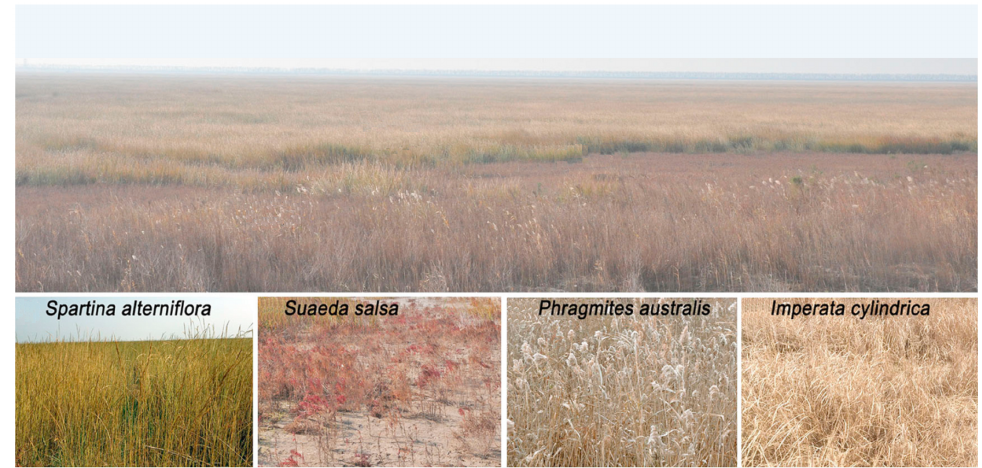
Figure 3. Salt marsh ecosystem in the middle coast of Jiangsu, China (33 ◦ 00 (cid:48) –33 ◦ 40 (cid:48) N, 120 ◦ 30 (cid:48) –120 ◦ 55 (cid:48) E)